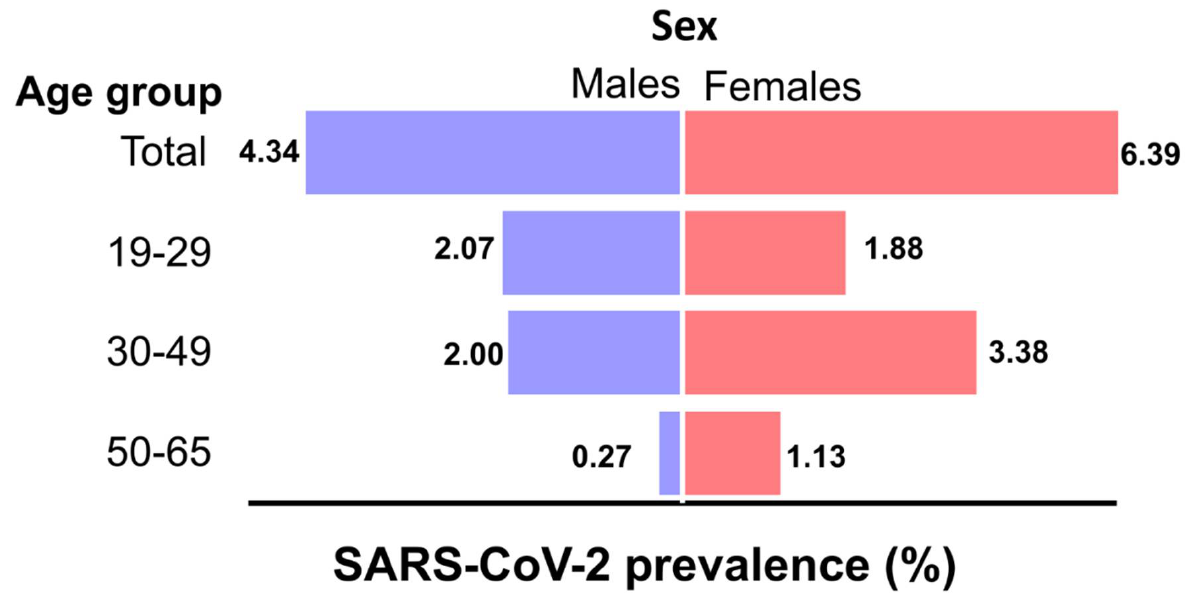
Figure 2. Sex and age distribution of SARS-CoV-2 IgG (+) samples. n = 99/2031.